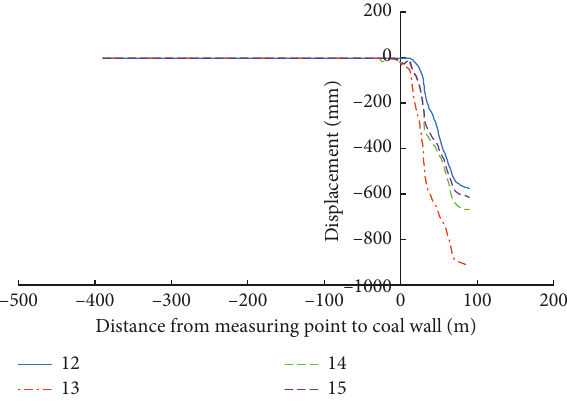
Figure 21: The displacement curves of the overlying strata at the fourth measuring